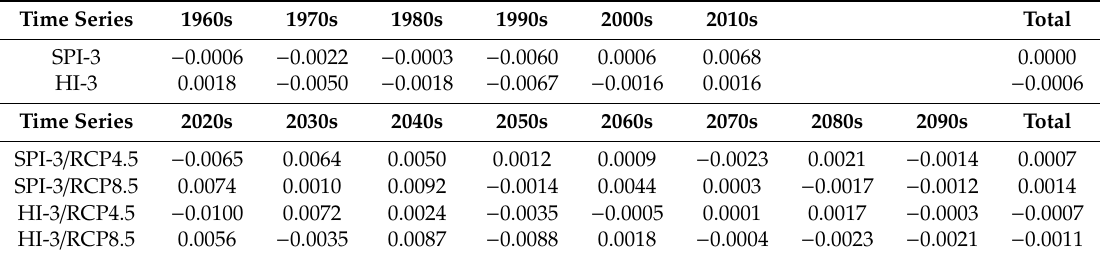
Figure 3. Time-series changes of standardized SPI and HI in past and future periods. Table 3. Interdecadal linear slope for the monthly SPI-3 and HI-3 in the past and future.